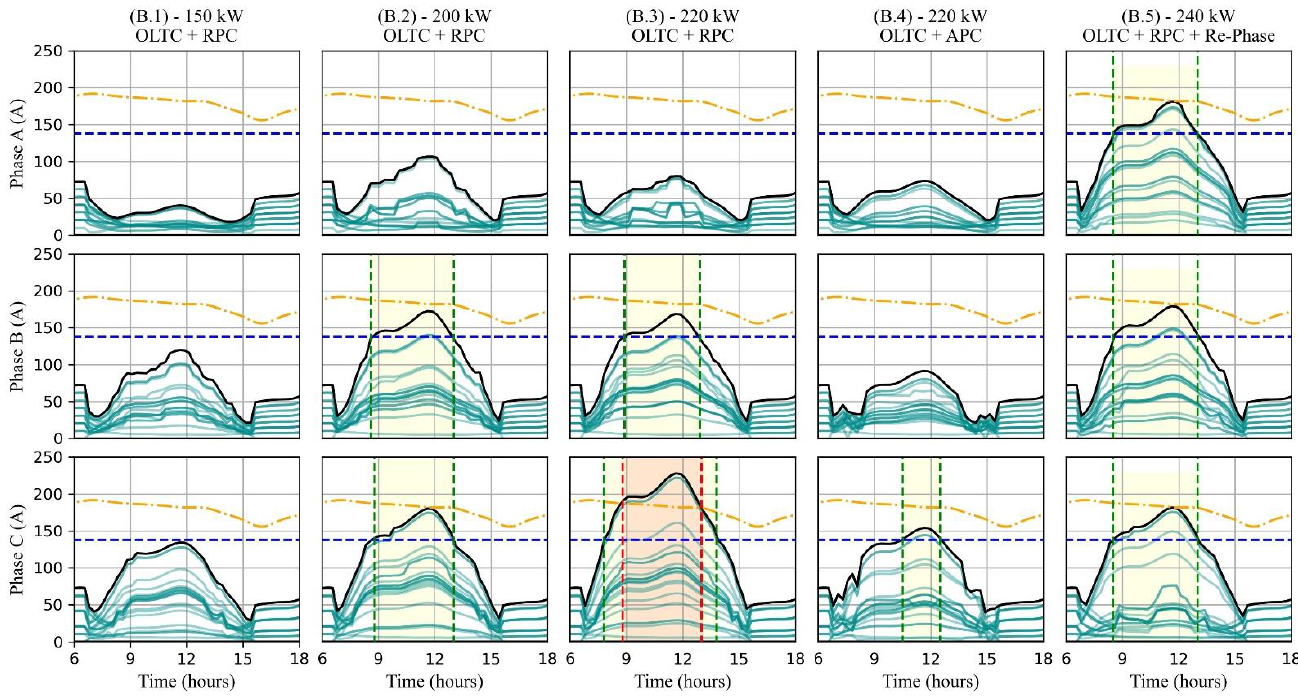
Figure 11. Time series variation of branch currents under different scenarios during PV generation. Figure 11 depicts the variations in branch currents that correspond to the previously described test scenarios under test case B in Table 1. In subplots in Figure 11, the blue dashed line indicates the SLR, whereas the orange dashed-dotted line represents 75% of the calculated DLR. Further to that, the maximum values in currents are shown in black solid